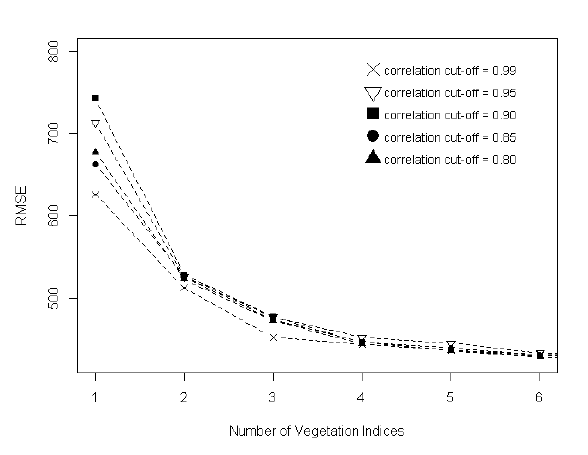
Figure 4 - Root-mean-square (RMSE) error for different feature filtering and selection cut-off levels.